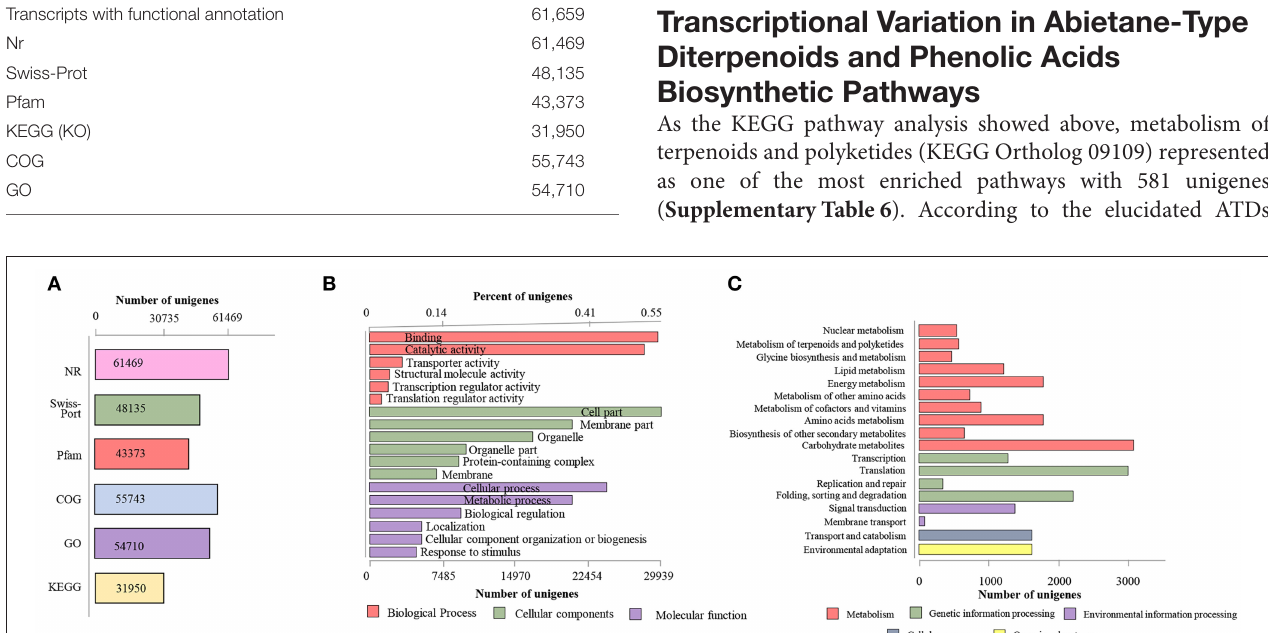
Frontiers in Plant Science |